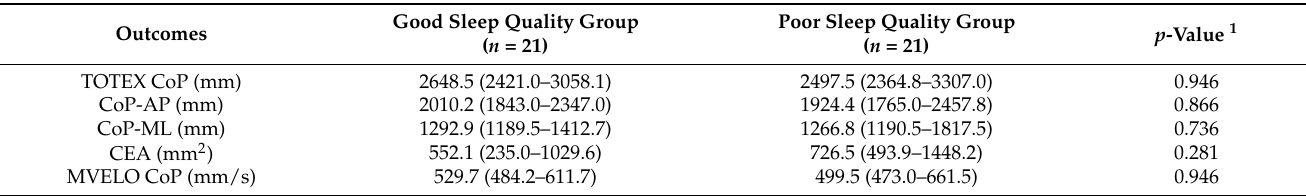
performing a cognitive task (dual task), median (IQR).